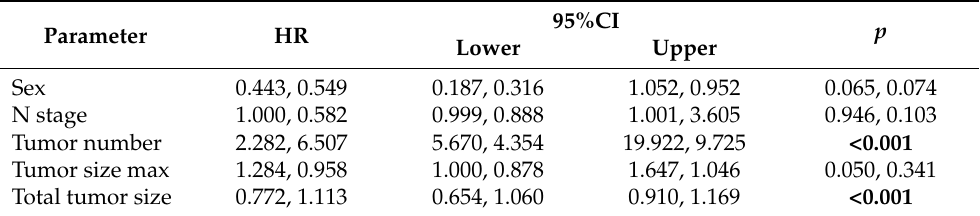
Table 2. Logistic regression analysis for potential risk factors of bilateral tumor spread in papillary microcarcinoma. HR hazard ratio, CI confidence interval. Table 3. ROC Analysis of the predictive value of the risk factors for total tumor size, Maximum tumor size, and Tumor number for bilaterality.